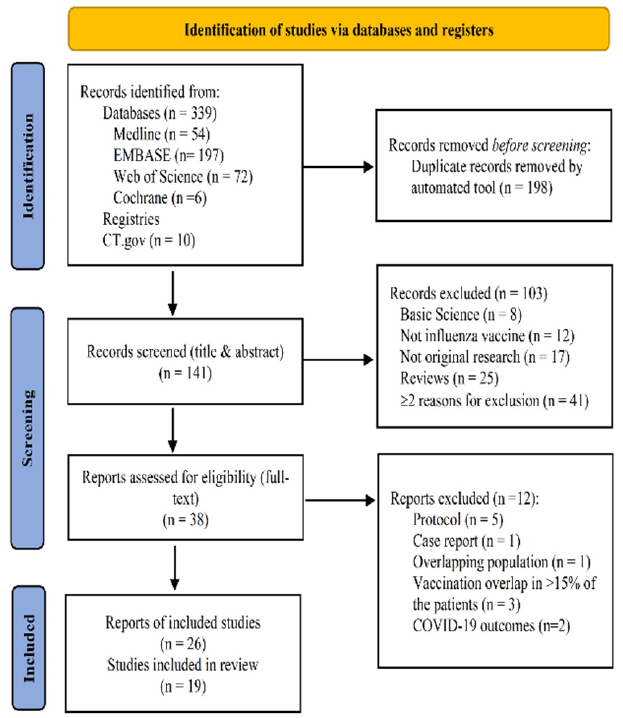
Figure 1. Diagram of study selection. CT.gov, ClinicalTrials.gov (accessed on 22 April 2022). Excluded studies . Five studies were ongoing and were excluded (ClinicalTrials.gov